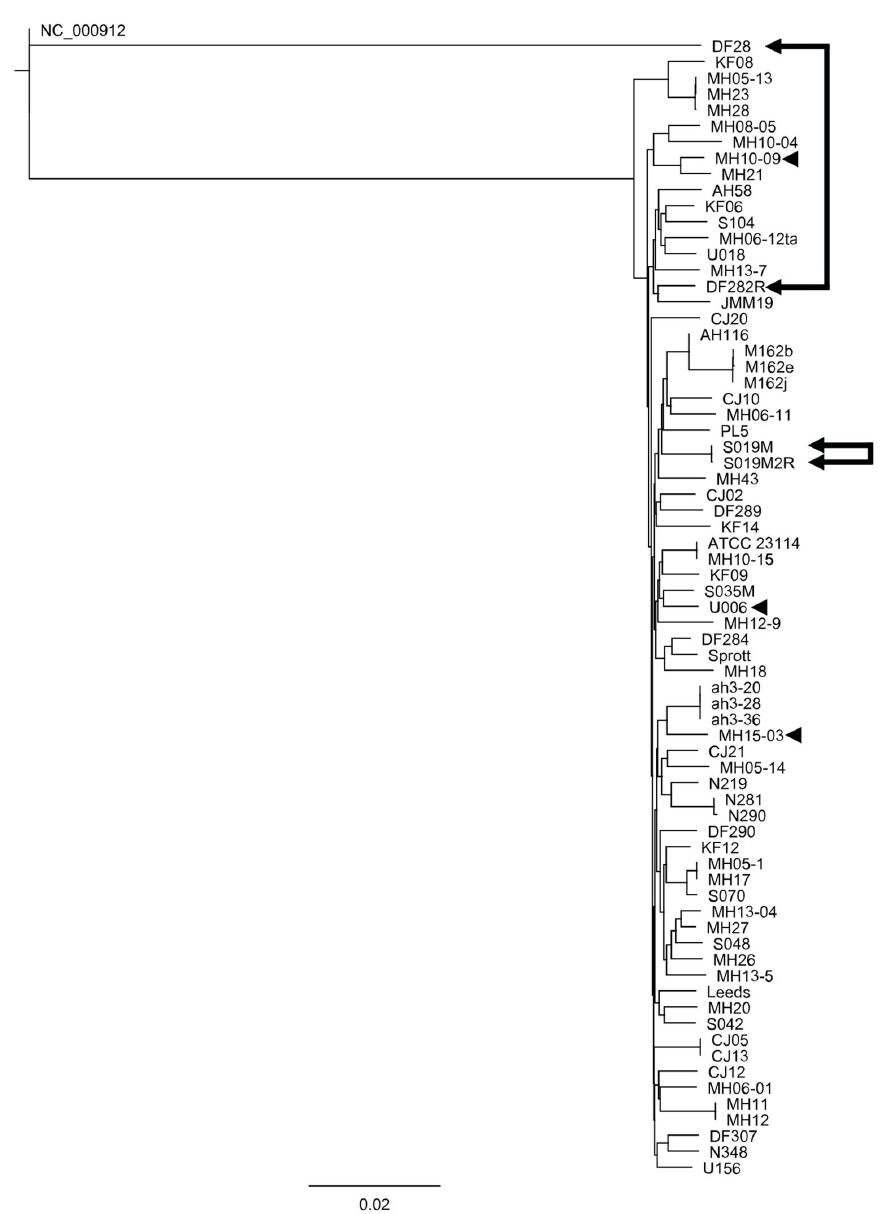
Figure 3. A phylogenetic tree of 72 isolates analyzed (and two induced resistant strains linked by arrows), constructed via concatenations of all four topoisomerase genes ( gyrA , gyrB , parC and parE ). The outgroup used was Mycoplasma pneumoniae M129, listed on the tree under its accession number (NC000912). Naturally occurring resistant strains are identified by arrowheads.